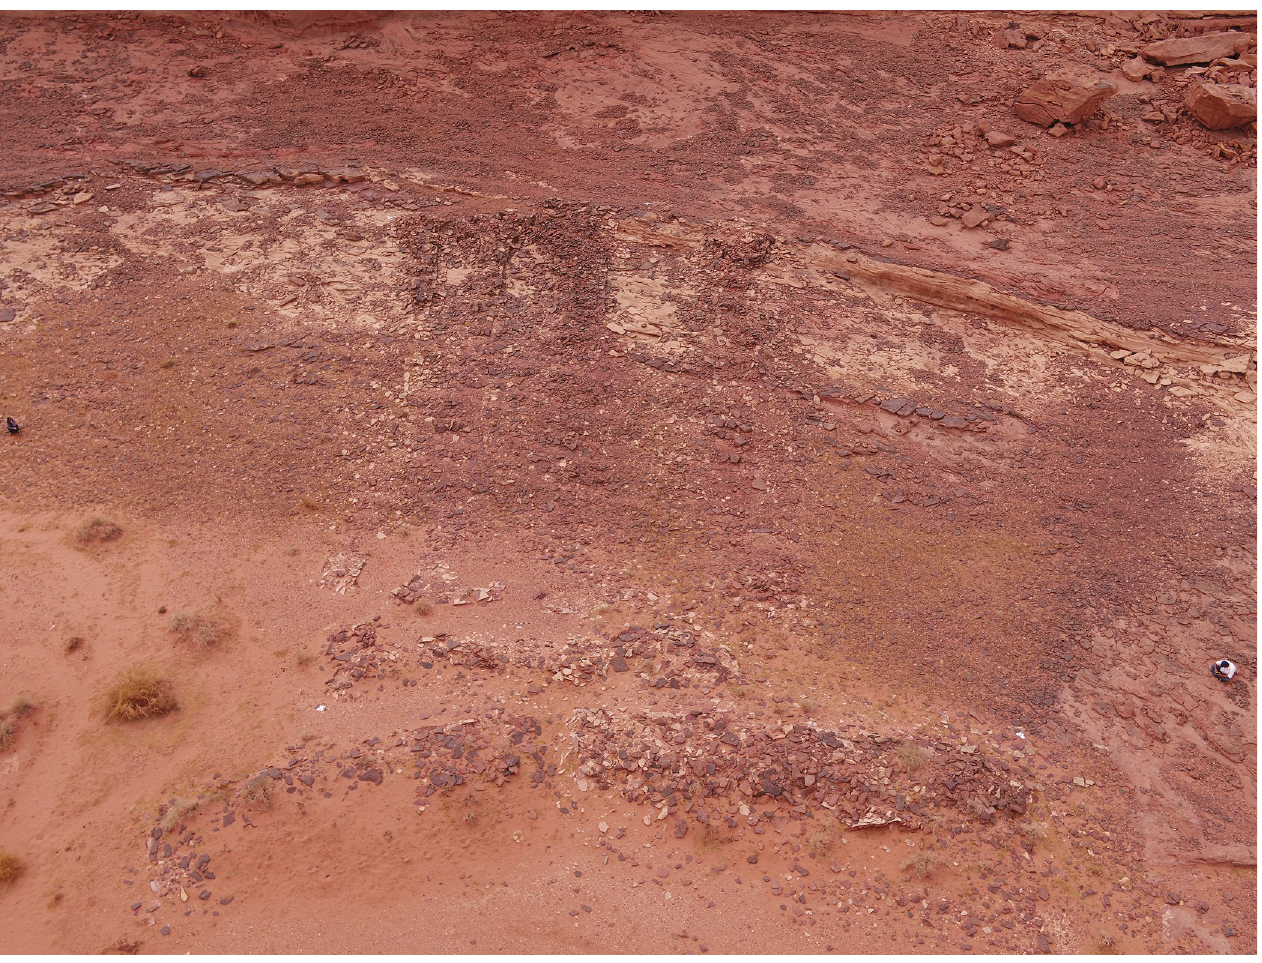
Fig 6. The four I-type platforms located west of IDIHA-F-0011081, photo orientated west.